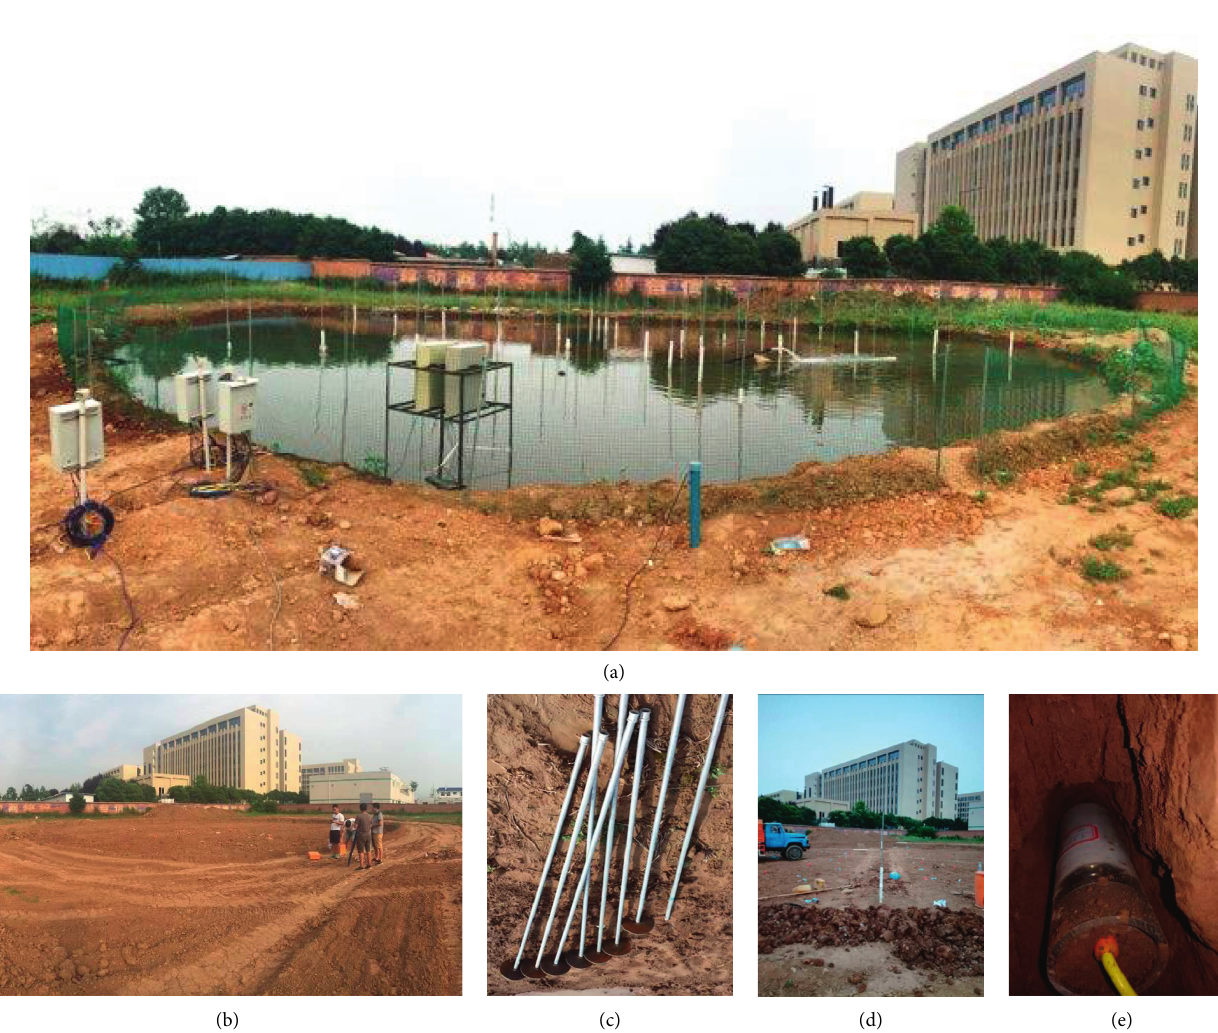
Figure 4: Site photos. (a) Overall view of the test pit. (b) Site leveling. (c) Shallow markers. (d) Deep markers. (e) Installation of the soil moisture sensor.